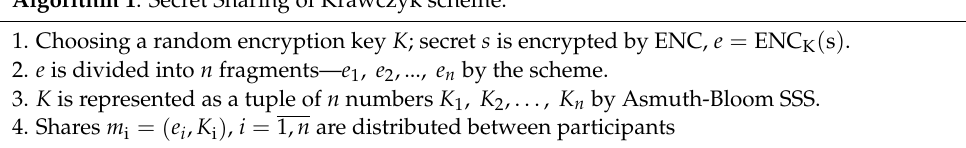
Algorithm 1 . Secret Sharing of Krawczyk